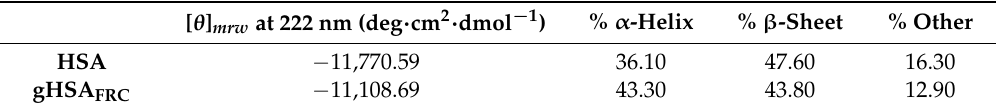
Figure 8. Far-UV CD spectra of non-glycated and glycated albumin (HSA, gHSA FRC ); protein concentration equals 5 × 10 −6 mol∙L −1 ; t = 37 °C. Table 2. The percentage (%) content of the secondary structure elements of HSA and gHSA FRC was calculated in Secondary Structure Estimation program using the Reed’s Reference model.